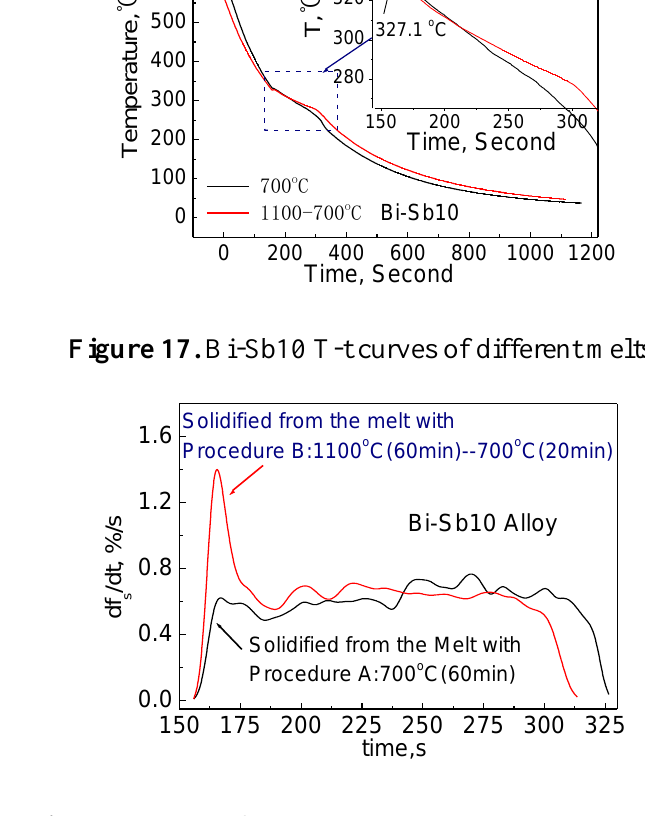
Figure 18. Solidification rate obtained by NTA